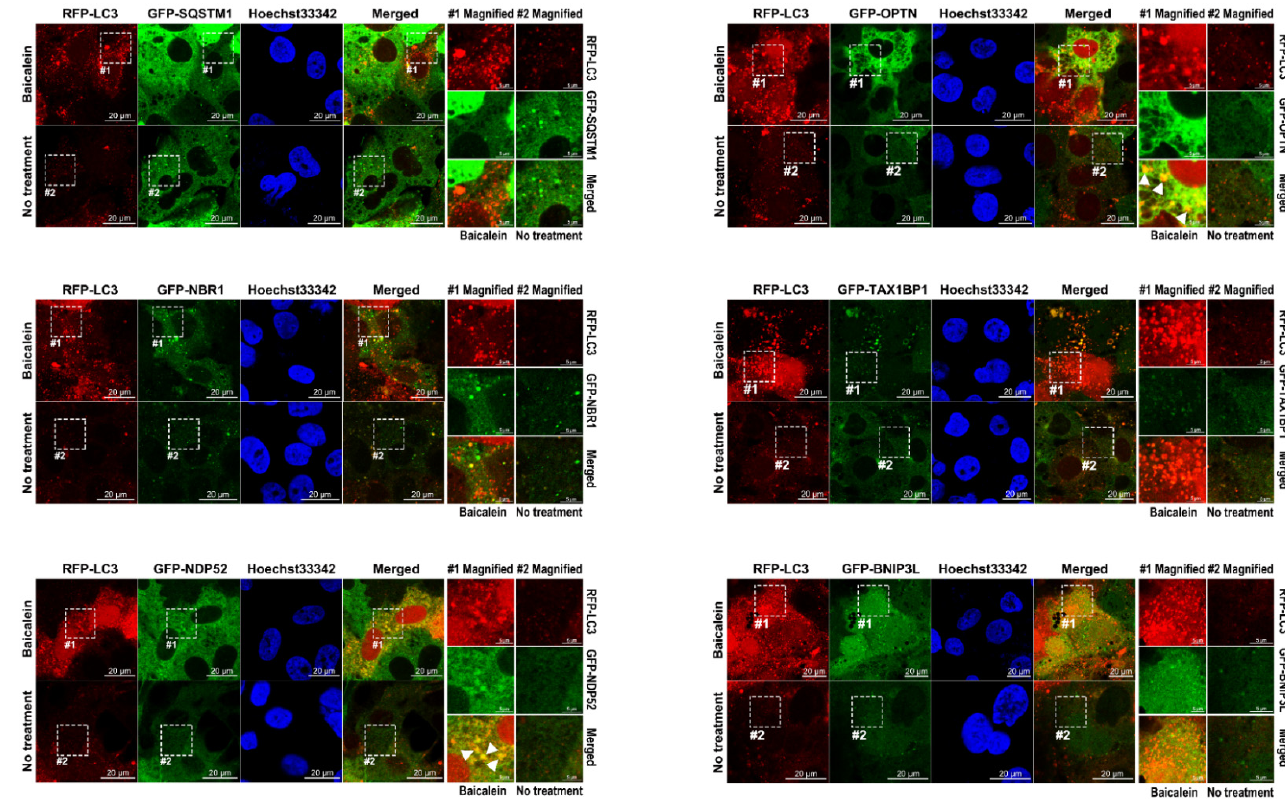
Figure 10. Analysis of the colocalization between cargo receptors and autophagic vacuoles in baicalein-treated cells. Huh7/RFP-LC3 cells were transduced with lentiviruses harboring GFP-SQSTM1, GFP-NBR1, GFP-NDP52, GFP-OPTN, GFP-TAX1BP1, and GFP-BNIP3L to generate Huh7/RFP-LC3/GFP-SQSTM1, Huh7/RFP-LC3/GFP-NBR1, Huh7/RFP-LC3/GFP-NDP52, Huh7/RFP-LC3/GFP-OPTN, Huh7/RFP-LC3/GFP-TAX1BP1, and Huh7/RFP-LC3/GFP-BNIP3L cell lines, respectively. The cells were treated with or without 0.5 mM baicalein for four hours. Then, the cells were fixed, stained with Hoechst 33342, and analyzed by confocal microscopy. Magnified field-1 and magnified field-2 in each panel show the enlarged images of the areas in white dashed boxes 1 and 2 in baicalein- treated and untreated cells, respectively. The white arrowheads in magnified field-1 indicate the colocalized signal.